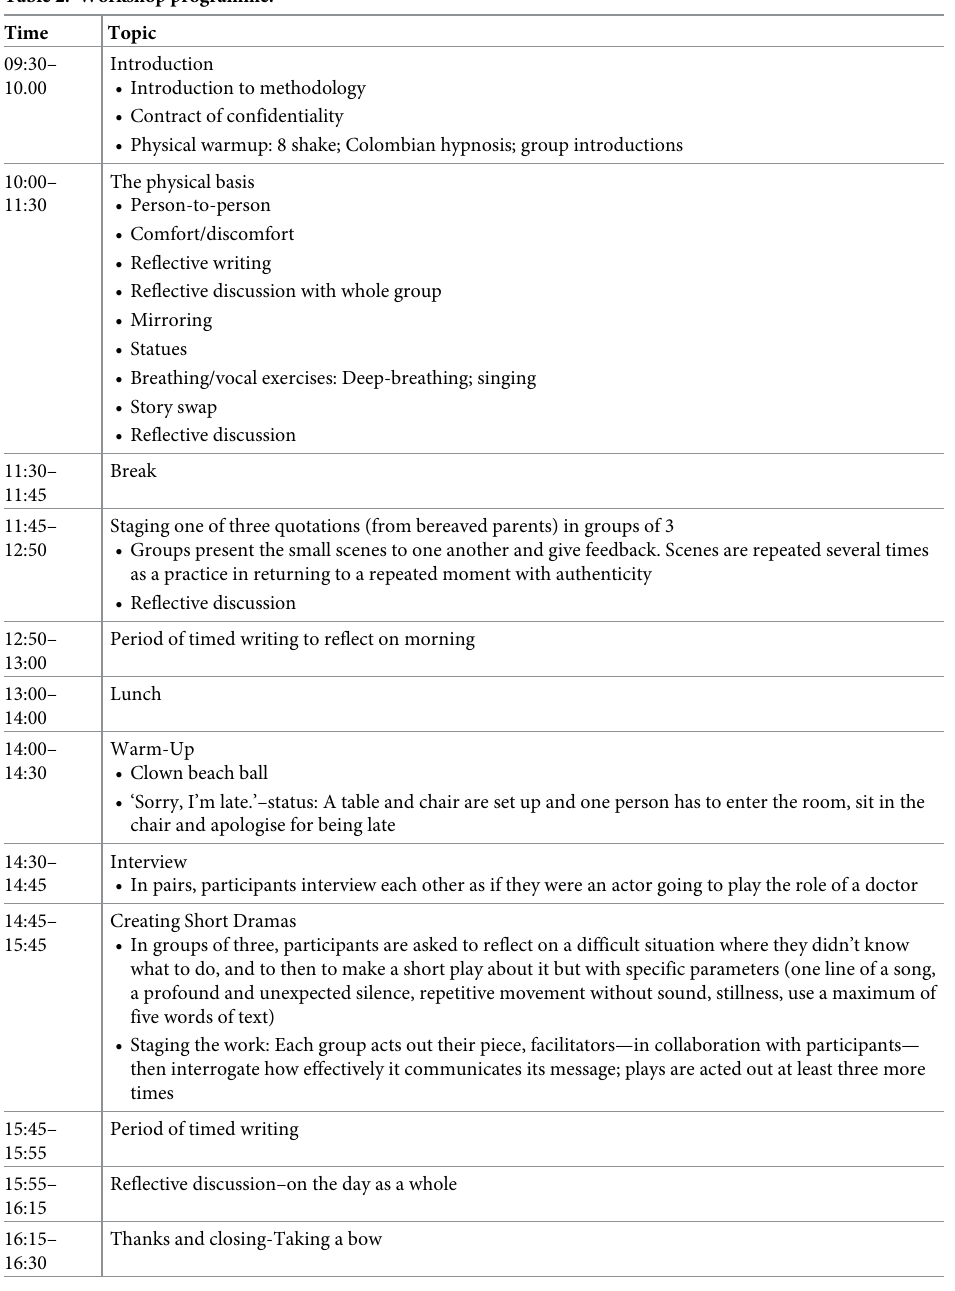
Table 2. Workshop